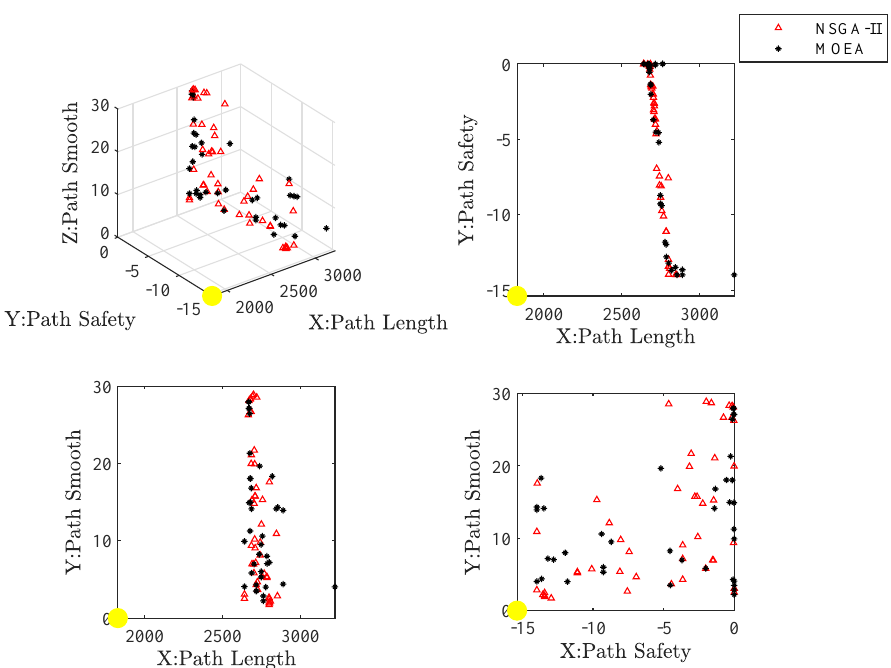
Figure 25. Based on Figure 11C, the approximate Pareto fronts generated by the two algorithms NSGA-II and MOEA. The sub-figure of the upper left corner shows the image of the approximate Pareto front in three-dimensional space. The remaining three sub-figures are the projections of the approximate Pareto front in the two-dimensional space.